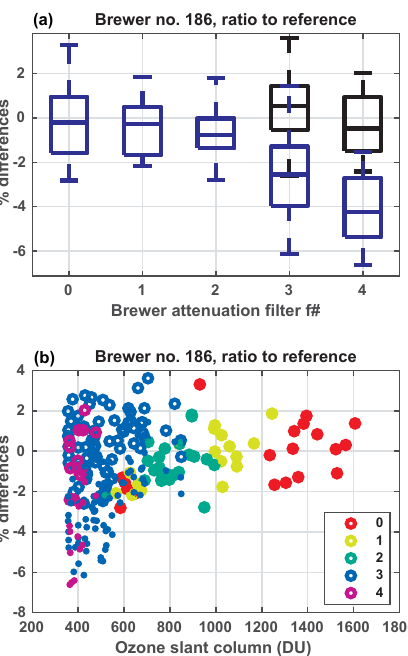
Figure 6. Box plot of the percentage differences with respect to the reference grouped by filter for Brewer no. 186, in blue without correction, and in black after applying the correction to filters 3 and 4 (a) . Panel (b) shows percentage differences with respect to the reference grouped by filter, without correction (solid dots), and after the application of the correction to filters 3 and 4 (open circles). Colours indicate the number of the filter; see the legend.